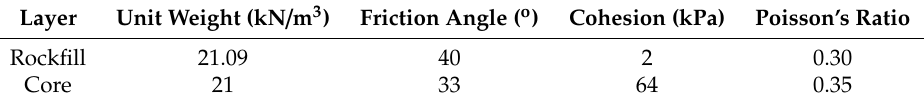
Table 2. Properties of the dam and foundation soil for the centrifuge